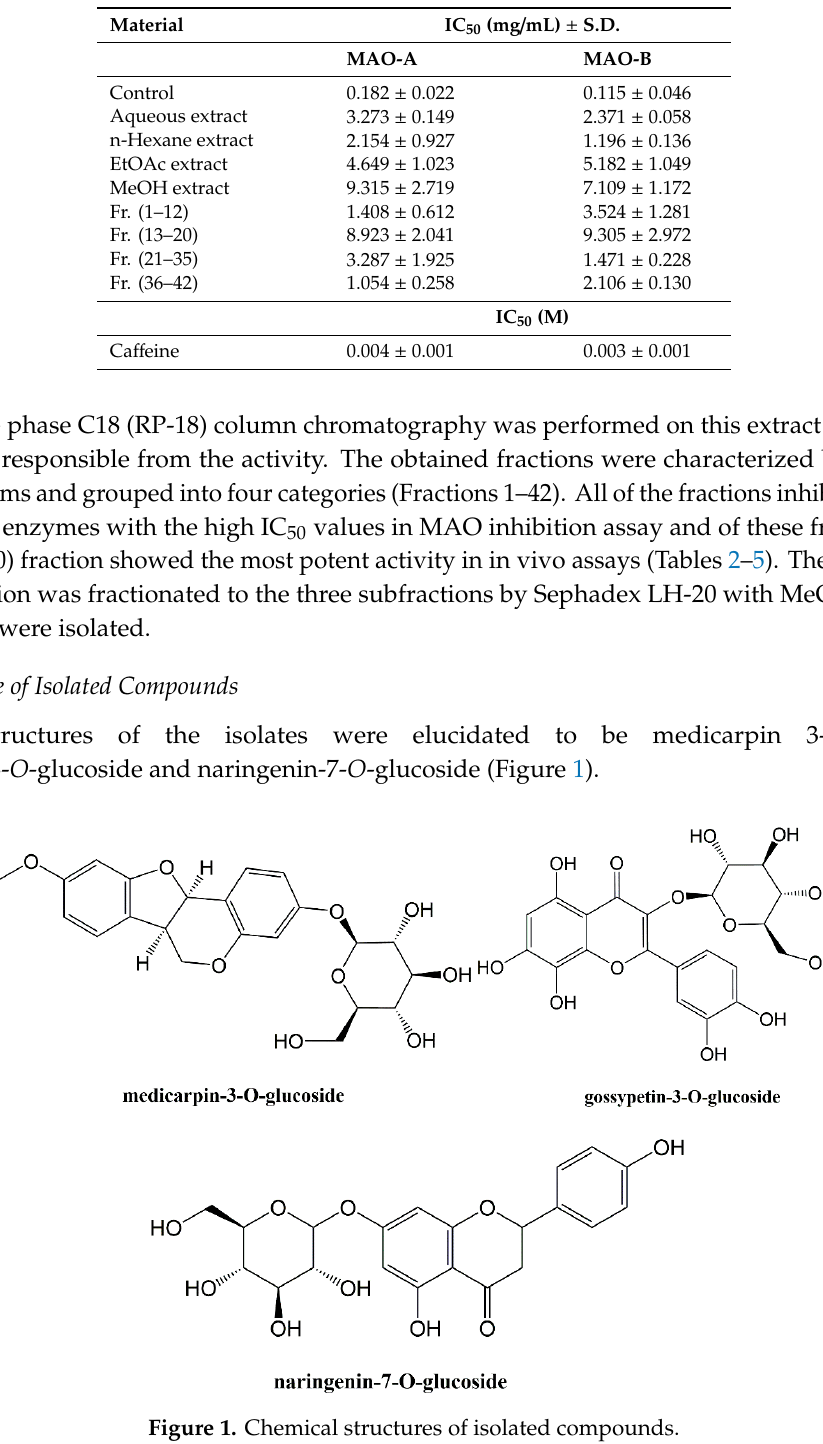
Table 5. E ff ect of extracts and fractions obtained from Lotus corniculatus L. subsp. corniculatus on the MAO inhibition assay.